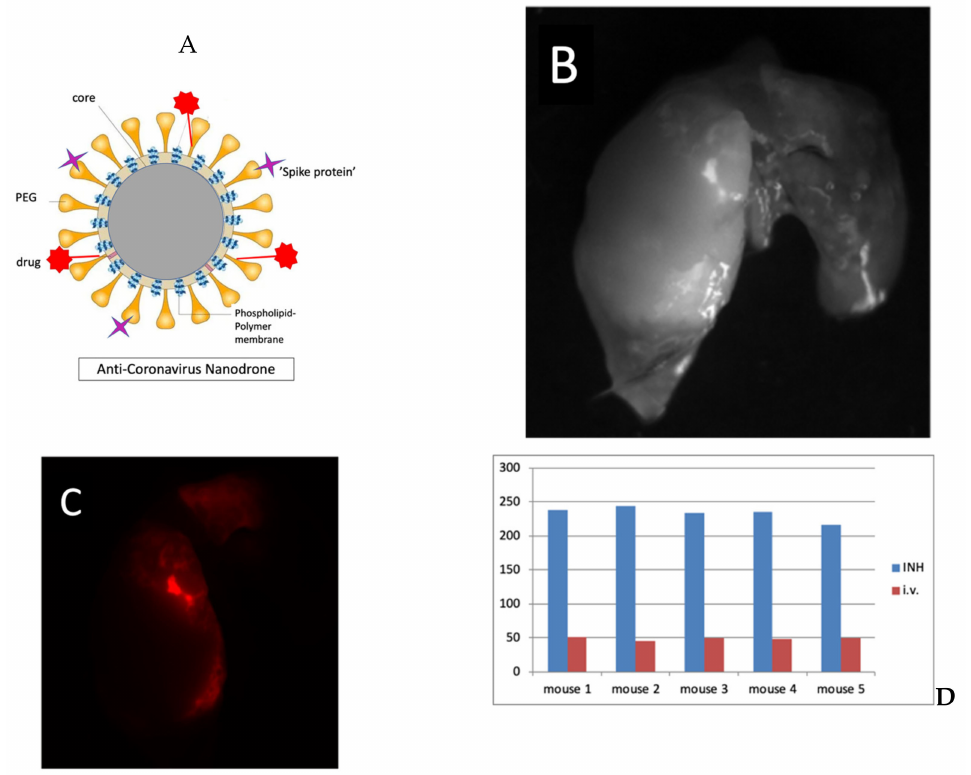
Figure 4. ( A ) A schematic of the anti-COVID-19 (AC) nanodrone designed to target ACE2 ( B – C ) results of smart nanoparticles (RGD-pGNPs) targeting lung lesions; ( D ) Fluorescence intensity